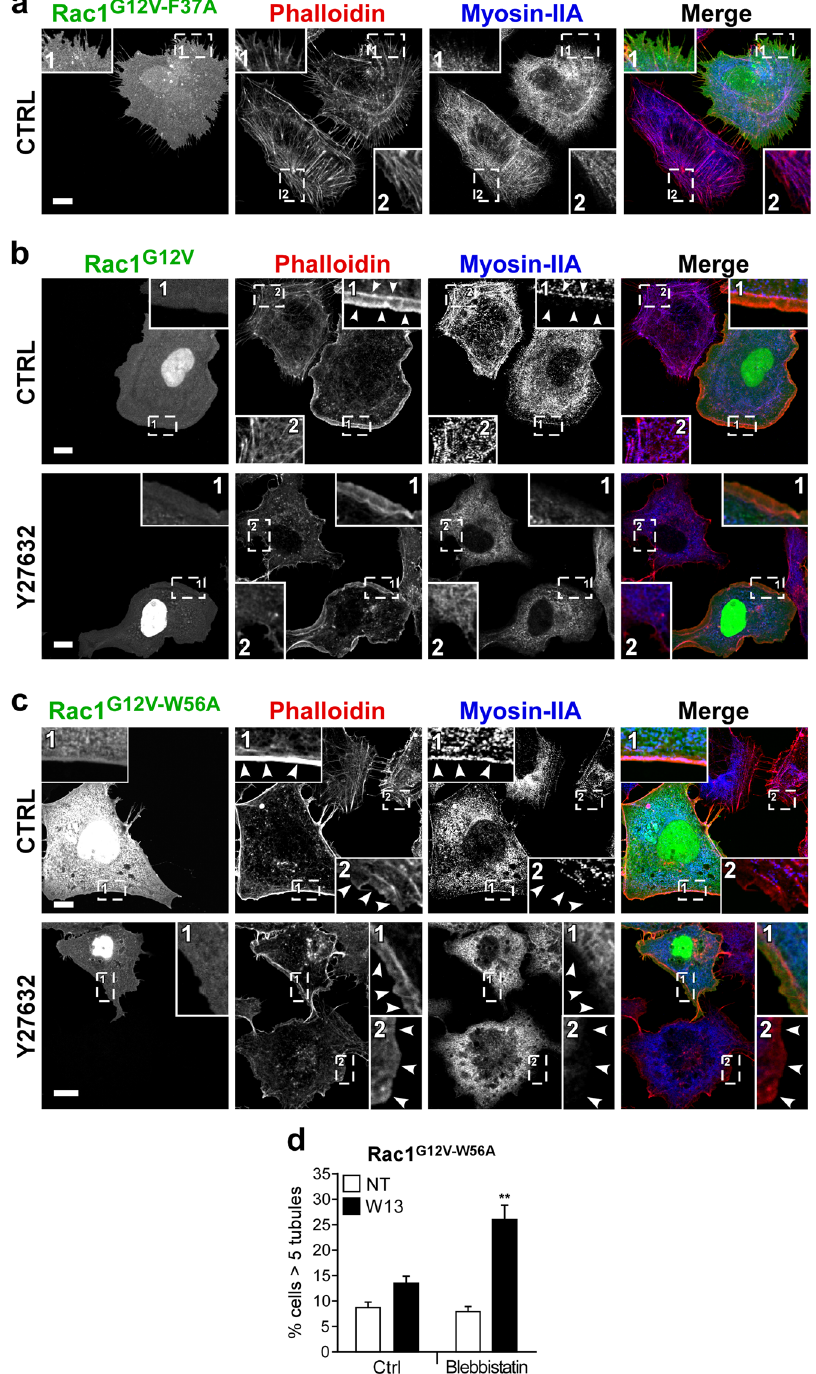
Figure 7. ROCK1 participates in Rac1 induction of actomyosin, and myosin activity is required for Rac1- mediated tubule inhibition. ( a , b , c ) By immunofluorescence, myosin IIA and F-actin were detected in starved Vero cells expressing GFP-Rac1 G12V-F37A ( a ), GFP-Rac1 G12V ( b ), or GFP-Rac1 G12V-W56A ( c ) after treatment with Y27632 (30 min, 25 µ M). The magnification insets show GFP-Rac1, phalloidin-A555, and myosin-IIA-A647 in transfected (1) and non-transfected cells (2). In the cells expressing GFP-Rac1 G12V and GFP-Rac1 G12V-W56A , the images show the loss of stress fibers (and consequently their staining with myosin II) plus myosin recruitment to cortical F-actin (arrow heads), which is reduced after treatment with Y27632 (bars, 5 µ m). ( d ) The percentage of cells presenting tubules was determined in the presence or absence of the myosin inhibitor blebbistatin (30 min, 50 µ M). Mean values ± standard error of the mean (SEM) from three independent experiments is shown. Statistical significance between different conditions was determined by Student’s t -test, * p <